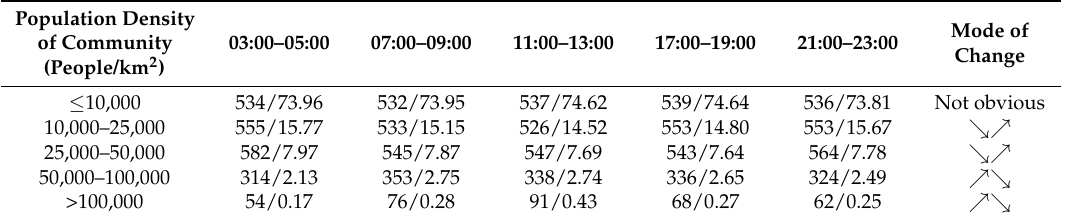
Table 4. Community number and area percentage (%) for different population densities in specific time